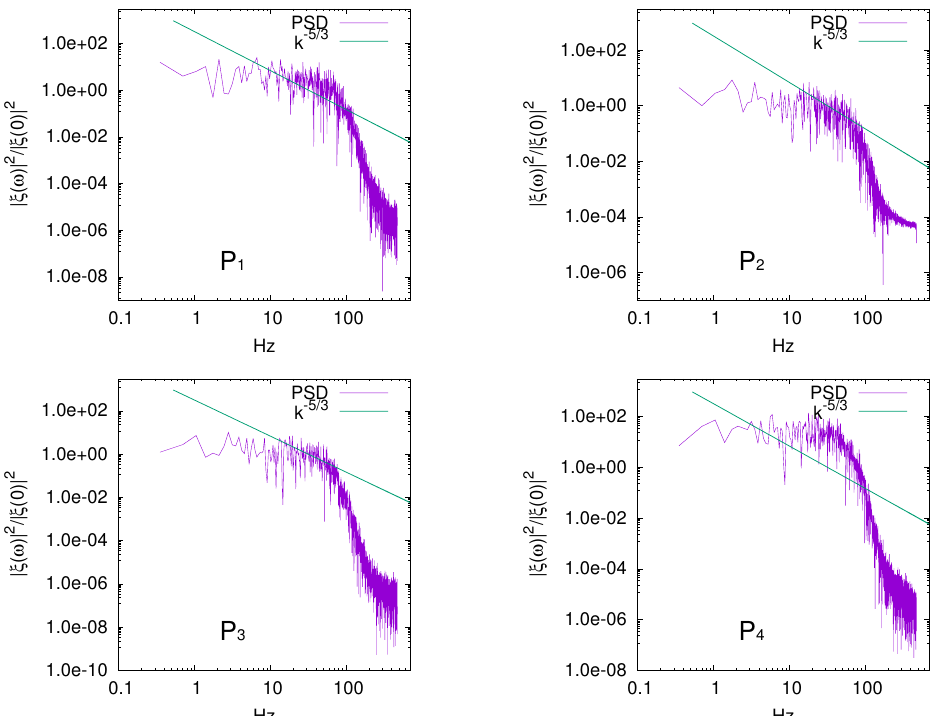
Figure 16. Kinetic energy Power Spectral Density (PSD) at probes P i with i = 1 to 4, left to right, top to bottom.